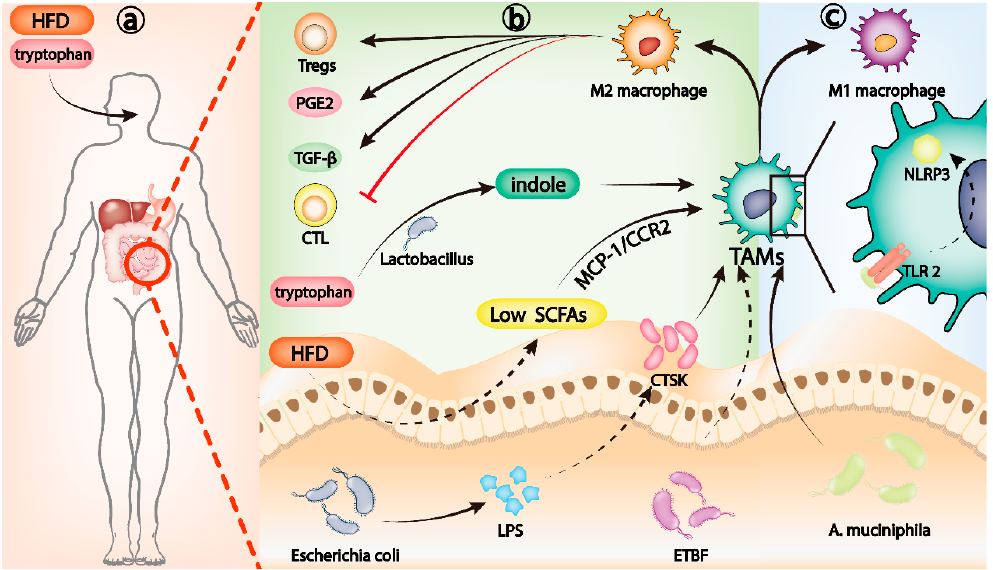
Figure 2. Gut microbiota, Th17 cells, and IL-17 families. ( a ) HFD can induce the dysregulation of gut microbiota and reduce the level of SCFAs. Low levels of SCFAs activate the MCP-1/CCR2 axis, which promotes the recruitment and polarization of M2 TAMs. Lactobacillus metabolizes dietary tryptophan into indole, which can activate aryl hydrocarbon receptor (AhR) to transform TAMs to immunosuppressive phenotype. ( b ) LPS released by Escherichia coli can upregulate CTSK secretion and induce M2 polarization of TAMs. Dysregulation of ETBF can also induce M2 polarization of TAMs. M2-polarized TAMs can inhibit cytotoxic T lymphocytes (CTL), recruit Tregs, and release PGE2 and TGF- β to change the TME to an immunosuppressive microenvironment. ( c ) A. muciniphila induces TLR2/NLRP3-mediated recruitment and polarization of M1